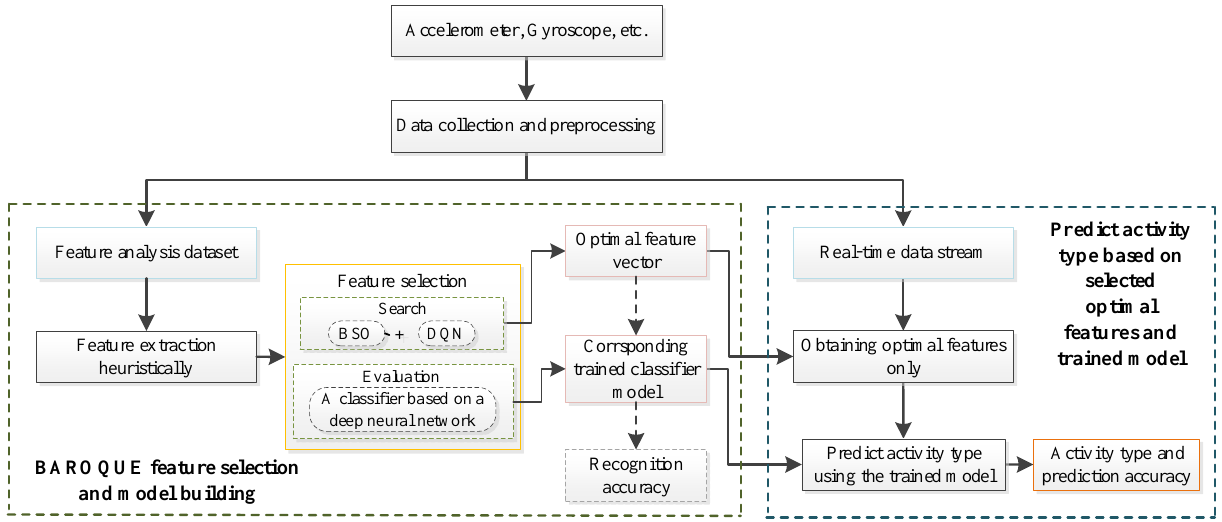
Figure 1. Structure of the proposed scheme for human activity recognition. It is made up of two stages: feature analysis and model building, and real-time human activity